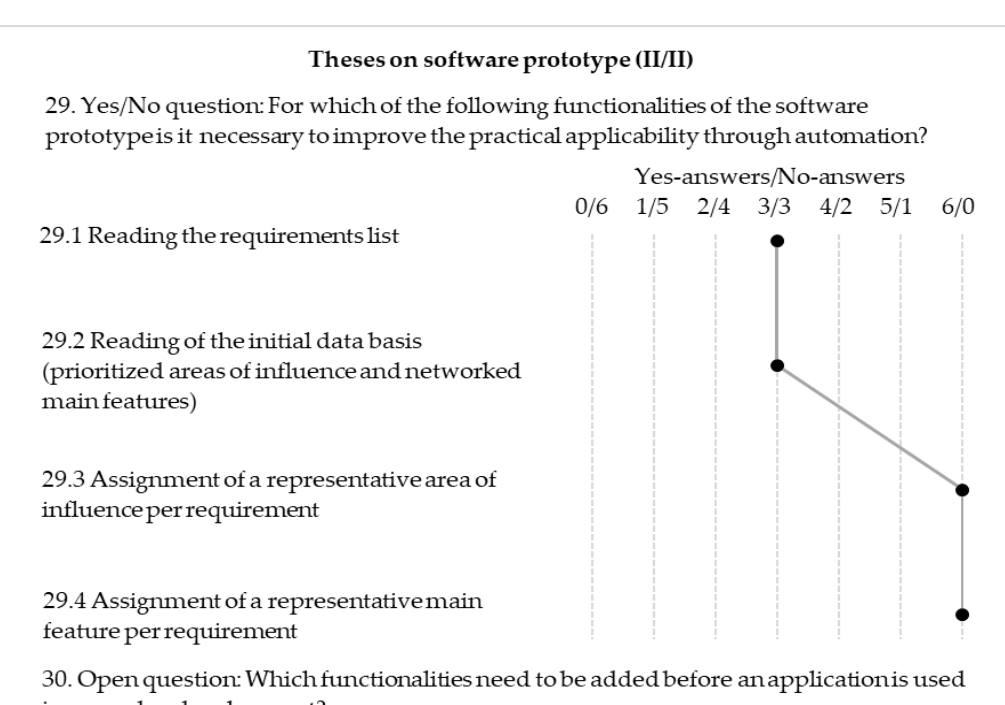
Figure A4. Questionnaire results on area “software prototype” – Part I/II.